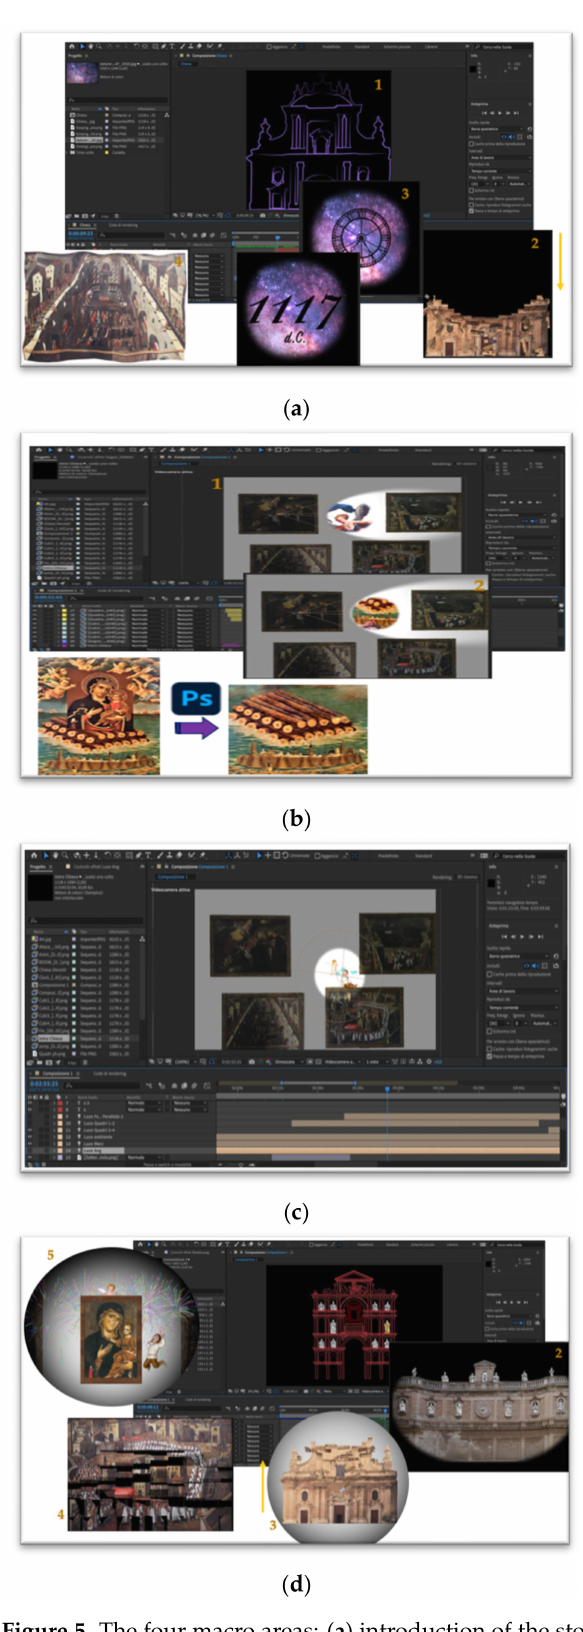
Figure 5. The four macro areas: ( a ) introduction of the storytelling, with the journey back in time; ( b ) how Mercurio’s dream is graphically represented; ( c ) an example of the 3D animation of the characters, jumping and running between the paintings; ( d ) the final scene with the story of the altarpiece and the joyful celebrations of the icon with